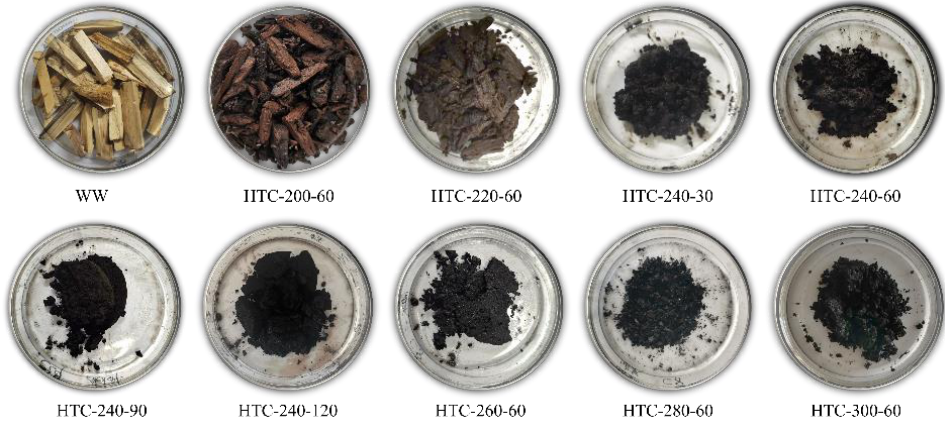
Figure 3. Morphology of different samples